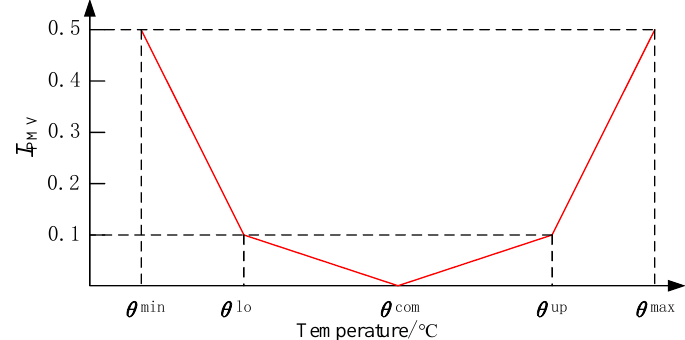
Figure 4. Users’ thermal comfort.